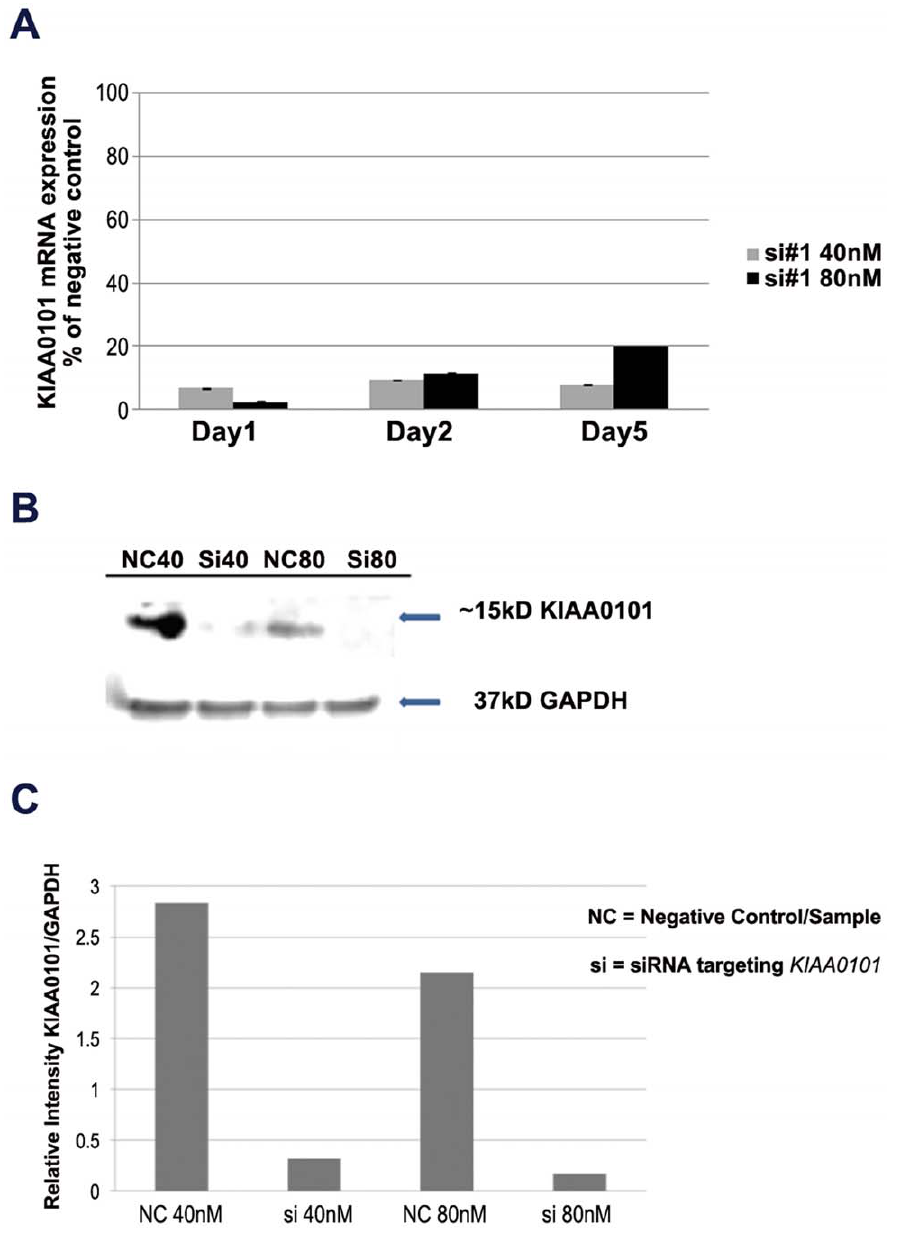
Figure 3. KIAA0101 mRNA and protein expressions were decreased with siRNA knockdown in the NCI-H295R adrenocortical carcinoma cell line. A ) H295R cells were transfected with KIAA0101 siRNA and negative control and analyzed for KIAA0101 mRNA expression after 48 hours of treatment. Columns represent KIAA0101 mRNA expression percentage relative to negative control 6 standard deviation of four experiments. B ) Representative Western blot demonstrating protein expression of KIAA0101 after 6 days of siRNA and negative control. C ) Relative intensity of western blot using Image J Software. Columns indicate ratio of KIAA0101 and GAPDH intensity measurements. NC40=Negative control at 40 nM; SI40 = siRNA at 40 nM; NC80 = Negative control at 80 nM; SI80 = siRNA at 80 nM.